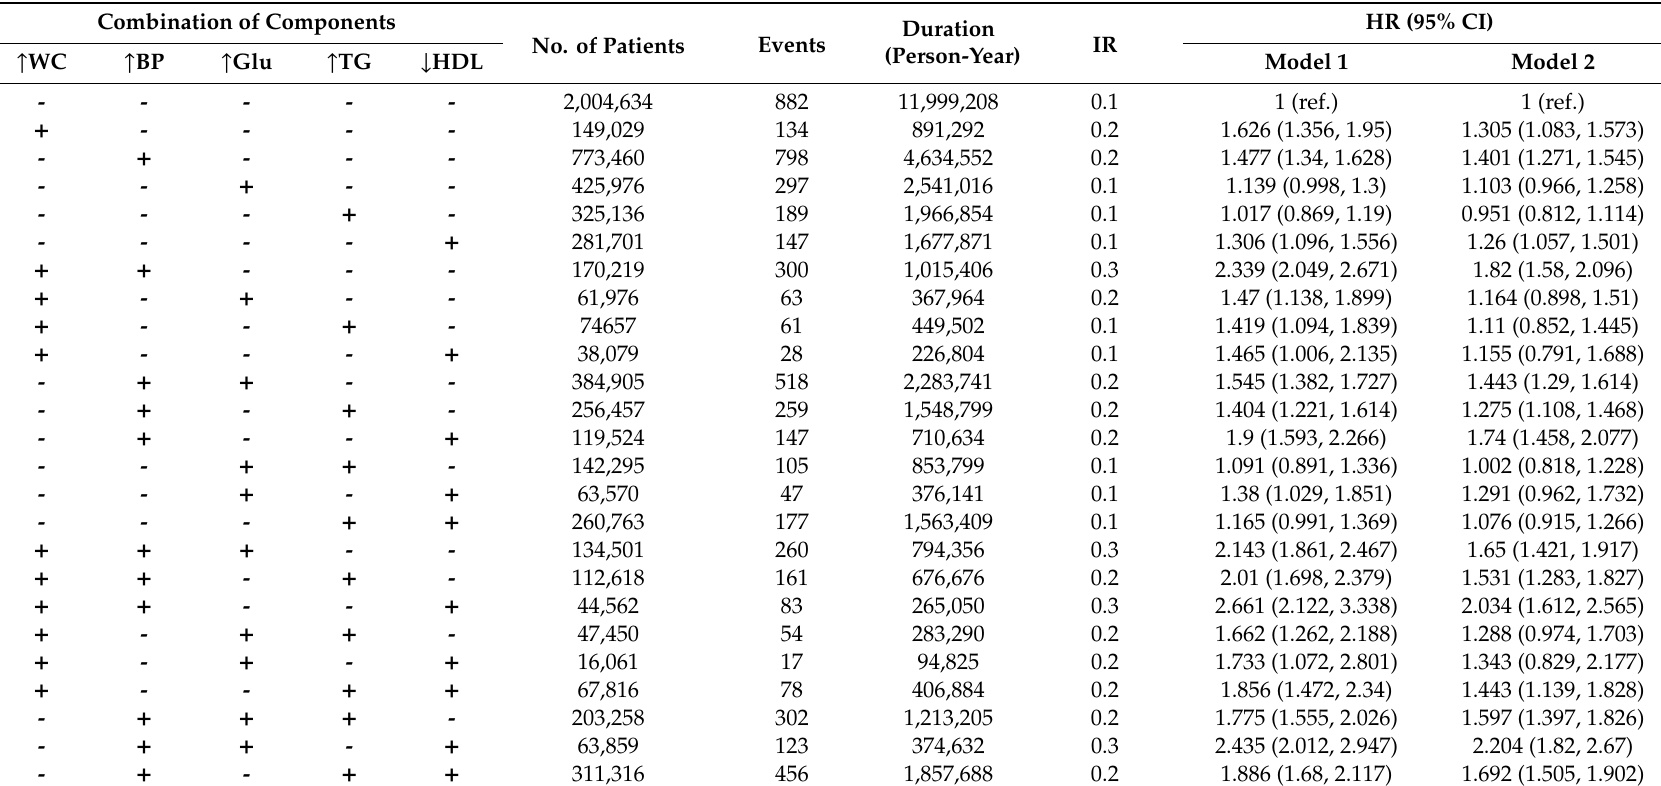
Table 1. Multivariate adjusted Cox proportional hazard regression models and incidence rates according to the combination of MetS components. Combination of